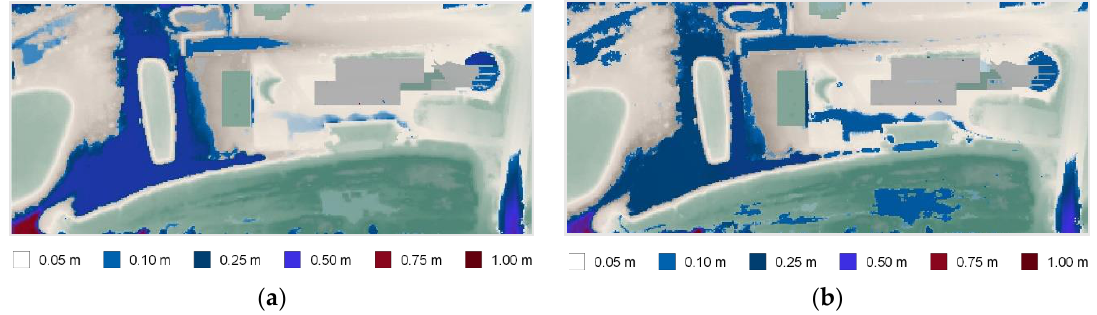
Figure 15. Comparison of the downsized model with the original model: ( a ) flood hazard map of the downsized model for a 100-year rain event with a duration of one hour generated by LISFLOOD- FP; ( b ) flood hazard map of the original model for a 100-year rain event with a duration of one hour generated by LISFLOOD-FP.